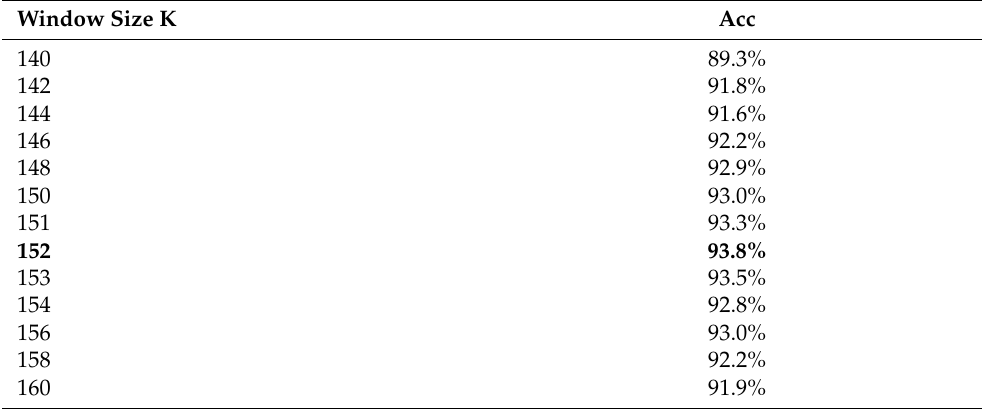
Table 2. Convolution window size.